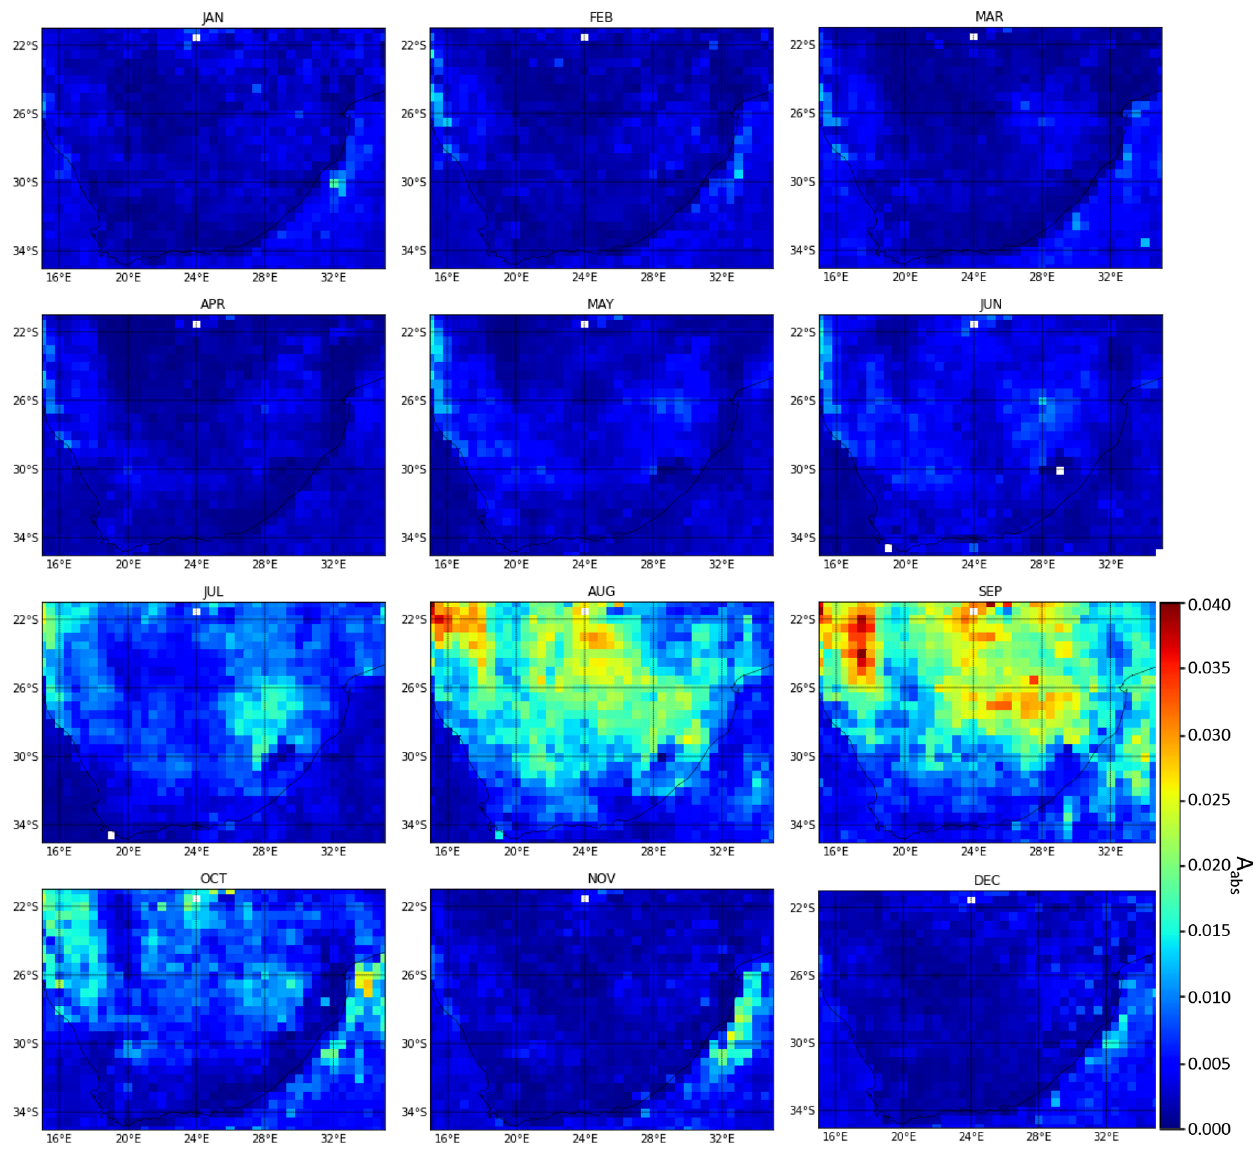
Figure 3. Average aerosol absorbing optical depth ( A abs ) over South Africa from MISR data for 10